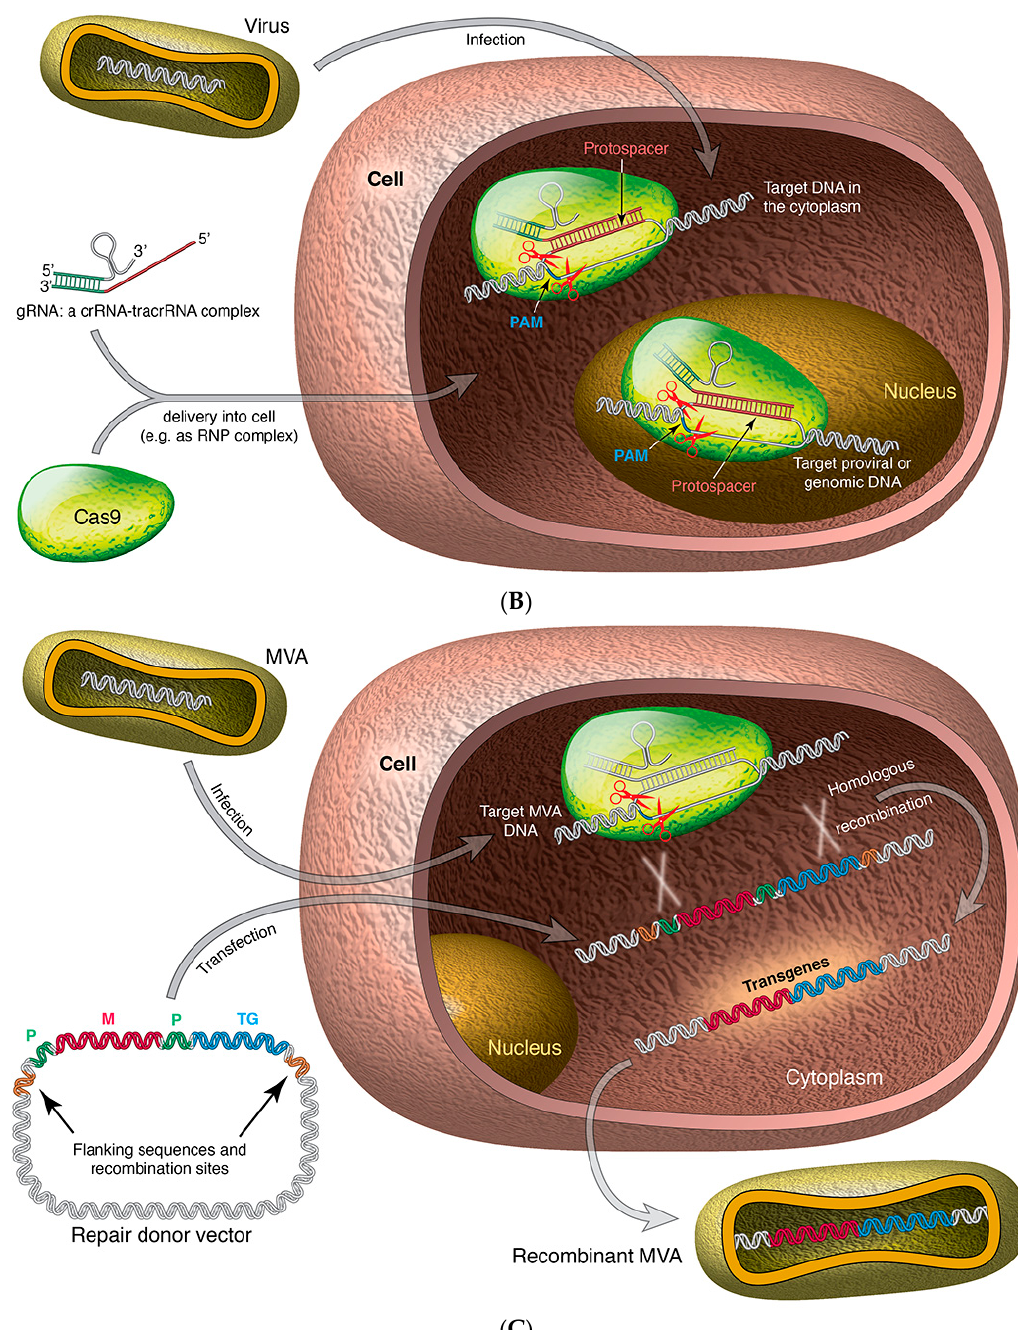
Figure 2. ( A ) crRNA and tracrRNA are fused to form the sgRNA; ( B ) sgRNA interacts with Cas9 and with a section (a short homologous sequence of about 20 nt –protospacer) on the target DNA (e.g., a virus, provirus or genomic DNA), thus directing the Cas9 to a specific site on a target DNA. The Cas9 nuclease activity results in a double stranded cut (indicated with the scissors) in the target DNA; the cut stimulates the cell’s DNA repair mechanism. RNP Complex: Cas9/gRNA Ribonucleoprotein. ( C ) In the presence of a DNA template with flanking sequences homologous to the cut regions of a target DNA, the Homology Directed Repair (HDR) mechanism can be activated and be exploited to generate a recombinant virus, e.g., recombinant MVA. M: marker gene; TG: foreign gene; and P: promoter.